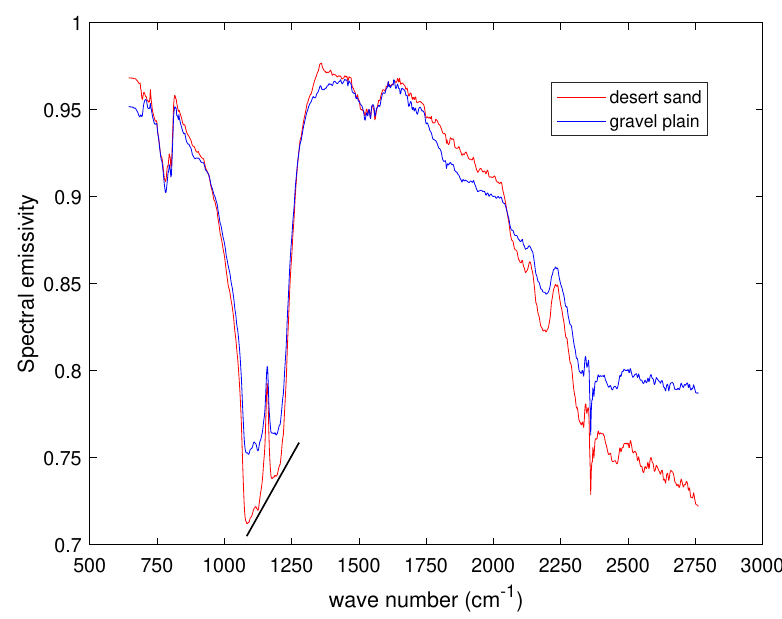
Figure 15. Comparison of retrieved emissivity for desert sand and the gravel plain, which have been obtained by averaging the spectra retrieved for the soundings shown in Figures 13 and 14. The black straight line connecting the reststrahlen band minima has a positive slope as expected for fine-grained quartz sand.